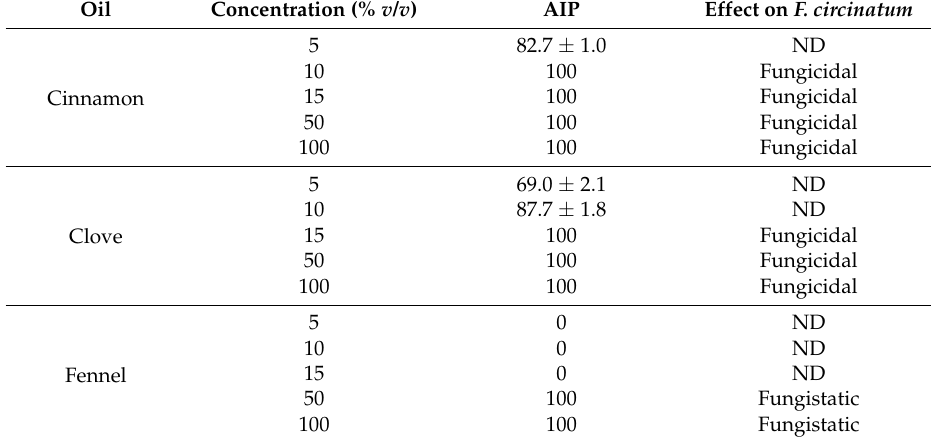
Table 1. Antifungal activities of essential cinnamon, clove, and fennel oils diluted with sweet almond oil. Area inhibition percent (AIP) was assessed after one week of exposure to the oil. The oils were determined to be fungicidal if no growth occurred after an inoculum was transferred to fresh media without oil or fungistatic if growth resumed after transfer. ND, not